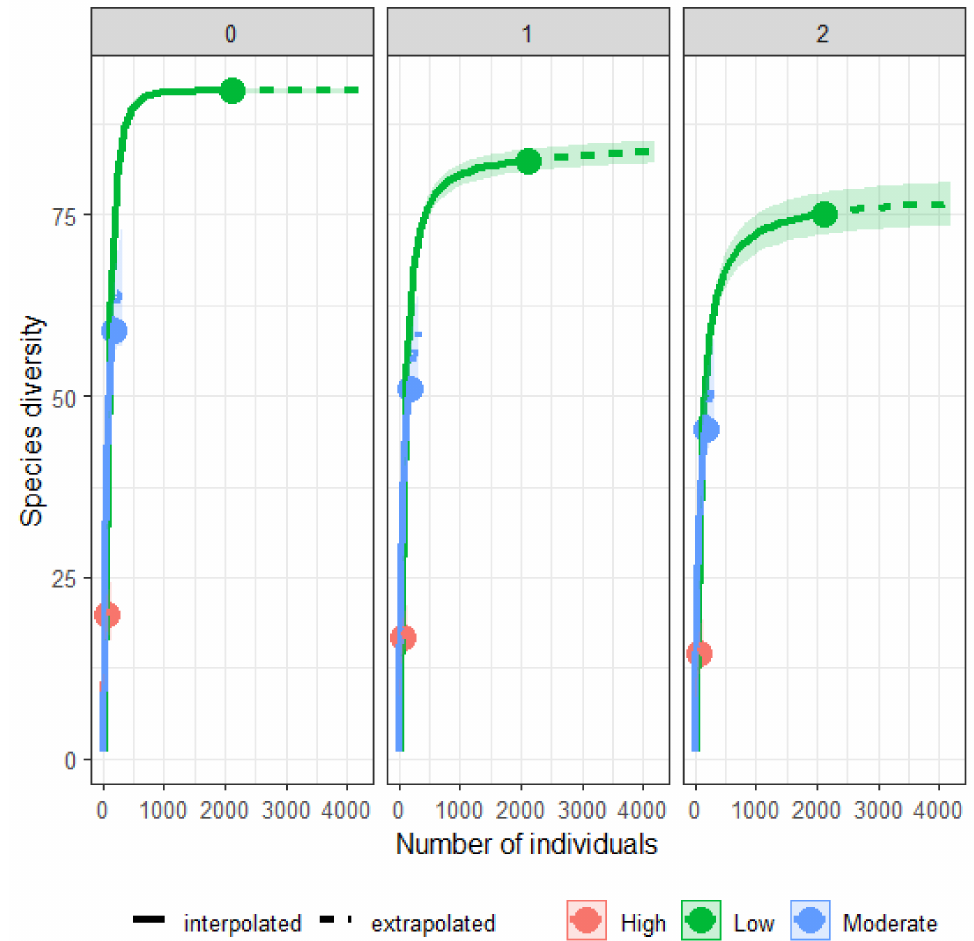
Figure 5. Comparison of tree species biodiversity between different land utilization regimes based on Hill numbers for different orders (0, 1, and 2). The solid and dotted line represent rarefaction and the extrapolation curve, respectively. The shaded area indicates the confidence interval at 95%, based on bootstrap method with 200